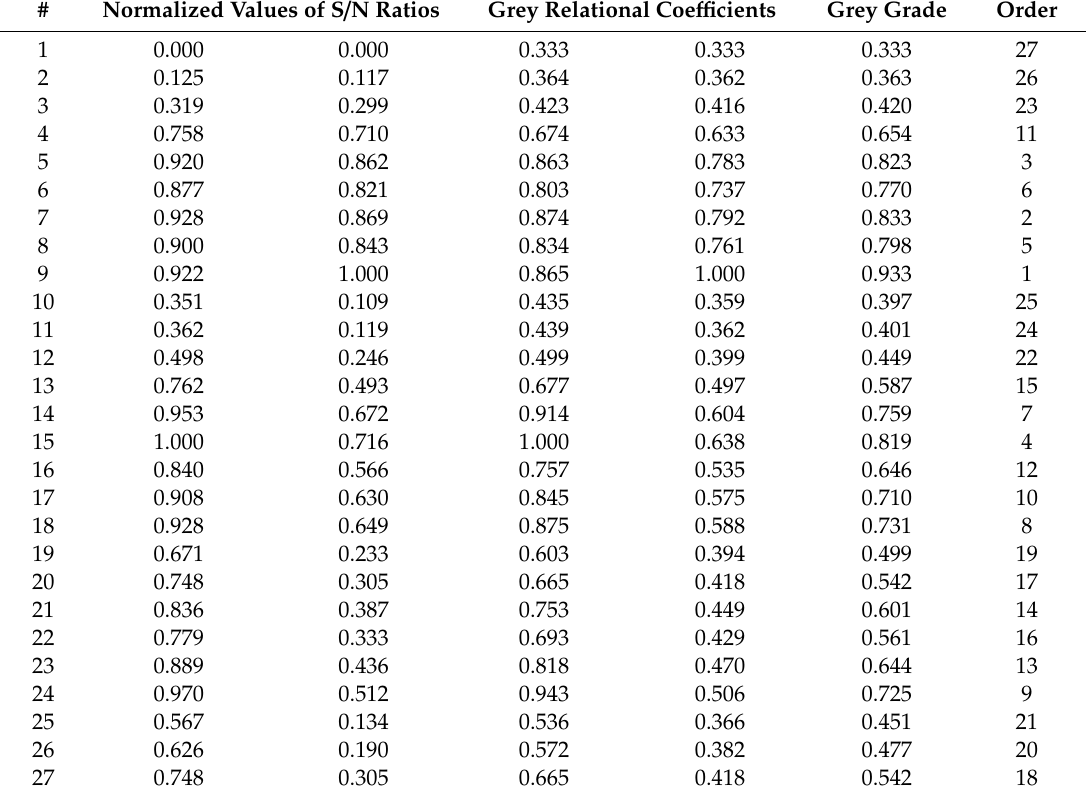
Table 3. Normalized values of S / N ratios and grey relational coe ffi cients.